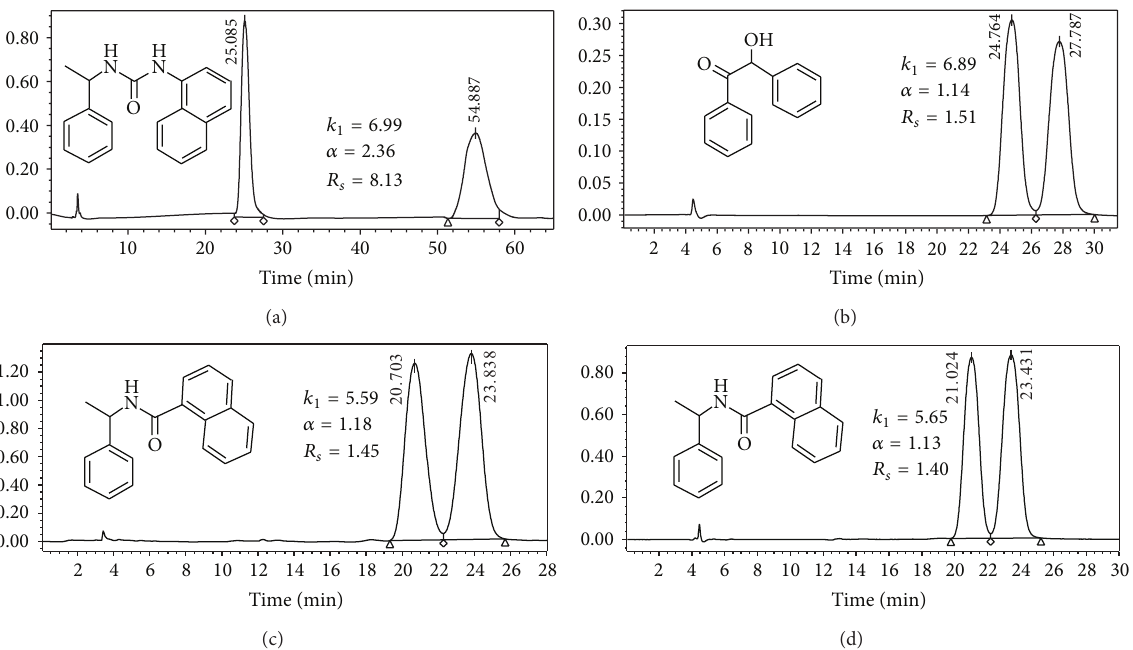
Figure 6: The typical chromatograms of the chiral compounds separated by CSP 2 . (a) compound 8; (b) compound 17; (c) compound 14; (d) the second time separation of compound 14 while the vacancy in the column input had been refilled. Mobile phase: n -hexane/ethanol/ methanol (90/5/5, v / v / v ); flow rate: 0.5